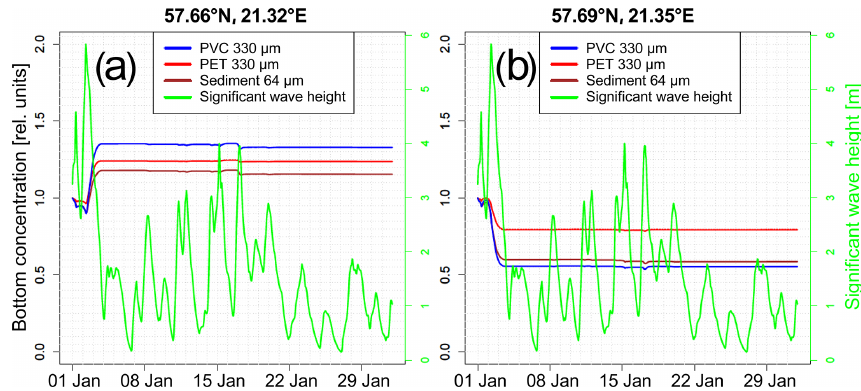
Figure 12. Evolution of the amount of PET and PVC with a 330µm diameter and sediment with a 64µm diameter on the seafloor during January 2019, starting from initial amount of 1kgm − 2 , at two grid cells, (a) with net deposition and (b) with net erosion.